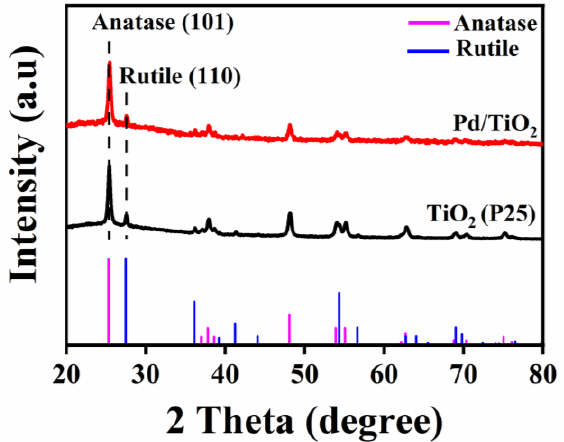
Figure 1. XRD patterns of TiO 2 and Pd/TiO 2 catalyst.